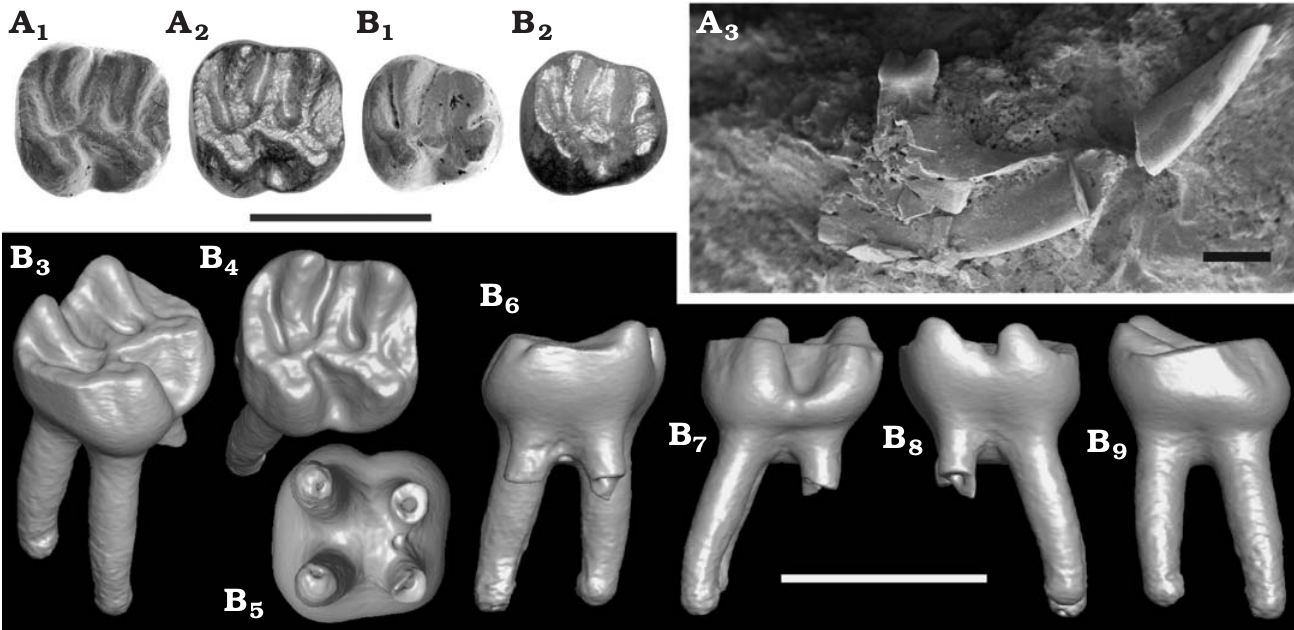
Fig. 2. Eomyid rodent Japaneomys yasunoi gen. et sp. nov. from the Dota locality, early Miocene. A . NMNS-PV19994, paratype, right p4. B . NMNS-PV19995, holotype, m1. In occlusal view (A 1 , A 2 , B 1 , B 2 ); SEM images (A 1 , B 1 ), HDR images (A 2 , B 2 ). Labial view of the right mandible with p4 (A 3 ). Surface model of m1: isometric (B 3 ), occlusal (B 4 ), bottom (B 5 ), anterior (B 6 ), labial (B 7 ), lingual (B 8 ), and posterior (B 9 ) views. Scale bars 1